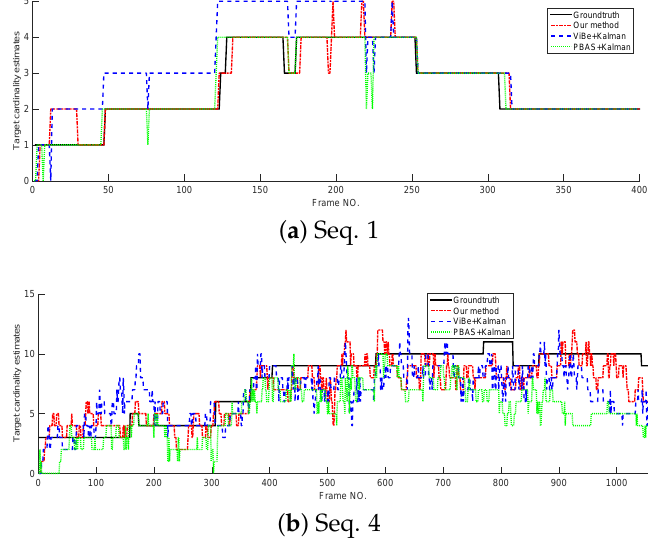
Figure 8. The cardinality estimates of different trackers.